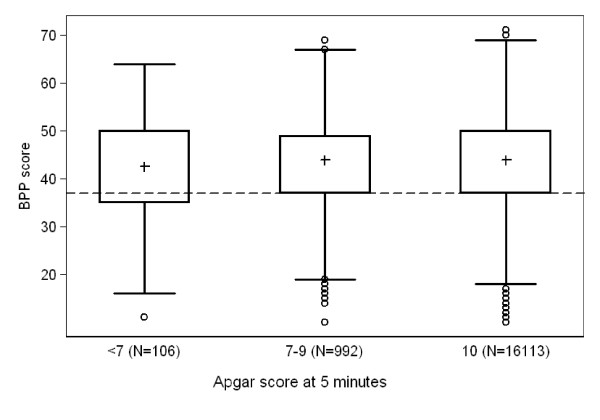
Box-and-whisker plots of Boerge Prien test scores converted to the conventional IQ scale (mean = 100, standard deviation = 15) according to Apgar score at 5 minutes. Pluses indicate median values; dashed line marks the bottom quartile of the overall distribution.